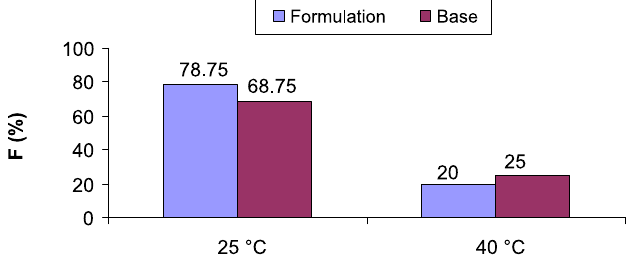
FIGURE 3 – In vitro occlusion potential of MeA and MeB samples kept at different